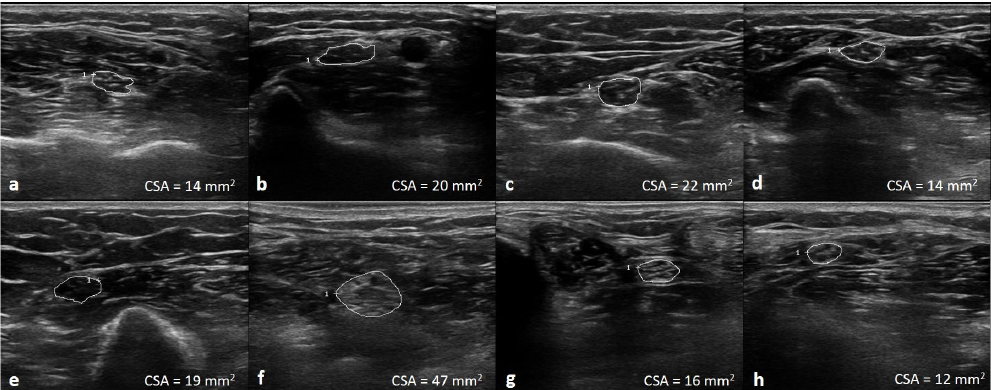
Figure 1. Illustration of the ultrasonographic nerve segments at median forearm ( a ), elbow ( b ), mid ‐ arm ( c ); ulnar forearm ( d ), mid ‐ arm ( e ); tibial knee ( f ), ankle ( g ); and fibular knee ( h ) of one of the CIDP patients. Total UPSA score: (2 + 2 + 2 + 2 + 2 + 2 + 1 + 1) =